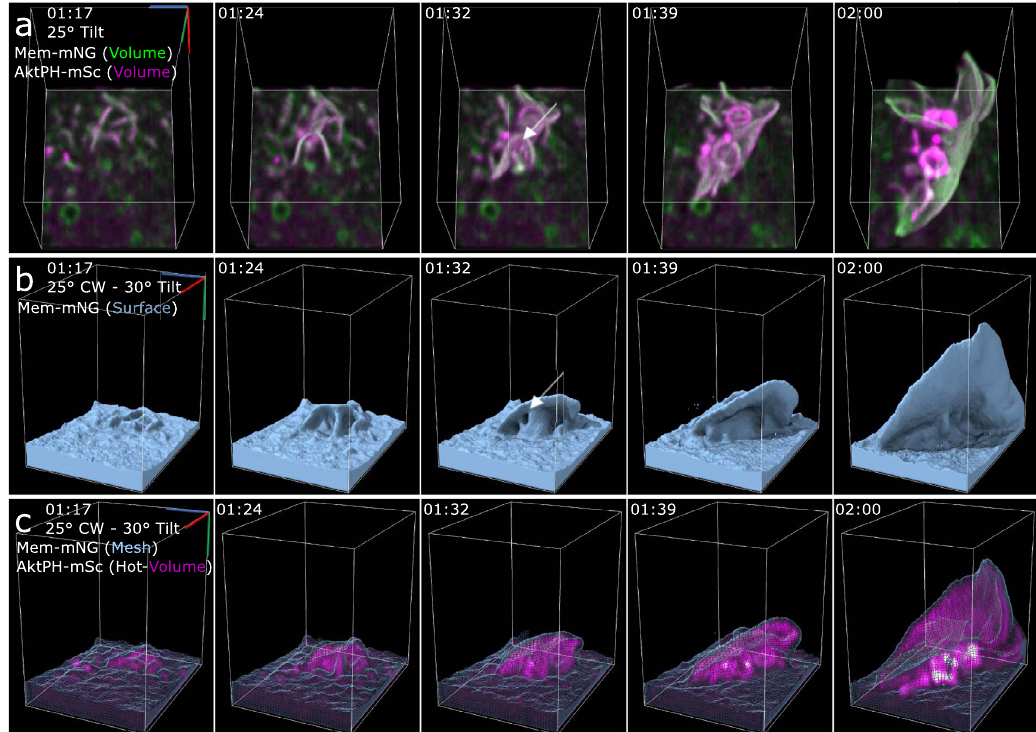
Fig. 4 Macropinosomes form via PI3K-primed ruf fl e fusion. a Dual volumetric intensities of Mem-mNG and AktPH-mSc show the intensity of each probe as the ruf fl es and macropinosomes form. The montage shows the earliest stage of the ruf fl e that extends vertically and forms macropinosomes along the length near the base of the primary ruf fl e as a result of smaller AktPH-mSc-rich extensions colliding. The white arrow points at the macropinosome- forming region further emphasized in the isosurface (region 9 × 12 × 13 µ m). b Isosurface rendering of Mem-mNG shows the structure of the extending ruf fl e and the continued sheet extension after the macropinosomes formed. The white arrow emphasizes the small pocket that closes to form one of the macropinosomes (region 9 × 12 × 13 µ m). c Mesh surface rendering of Mem-mNG and volumetric AktPH-mSc shows the internalized macropinosome with the increased localization of AktPH-mSc at the bottom of the ruf fl e (region 11 × 9 × 12 µ